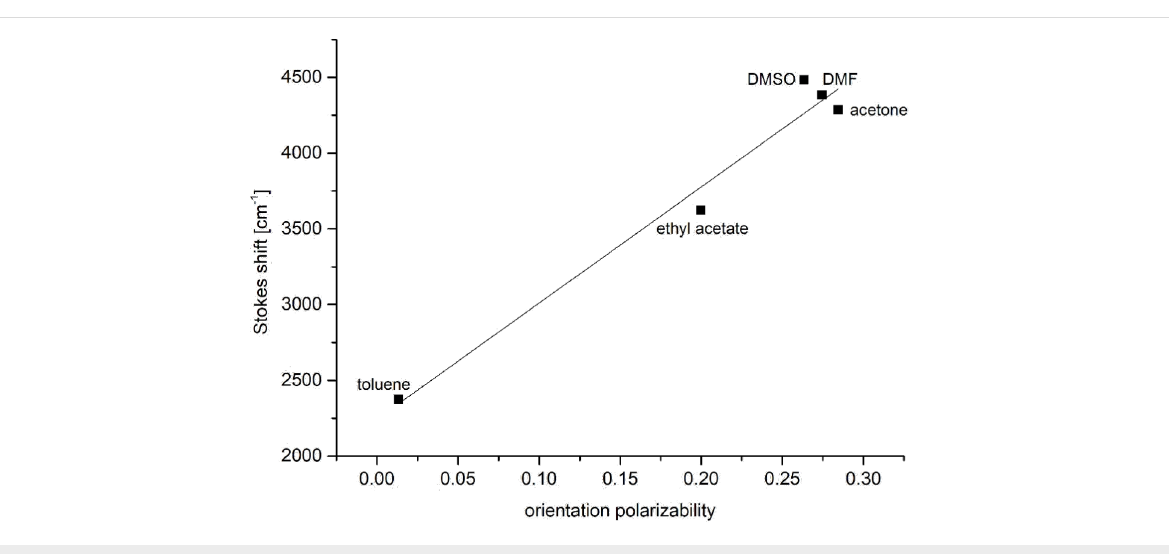
Figure 13: Lippert plot for α -pyrone 6c ( n = x, r 2 = 0.970).